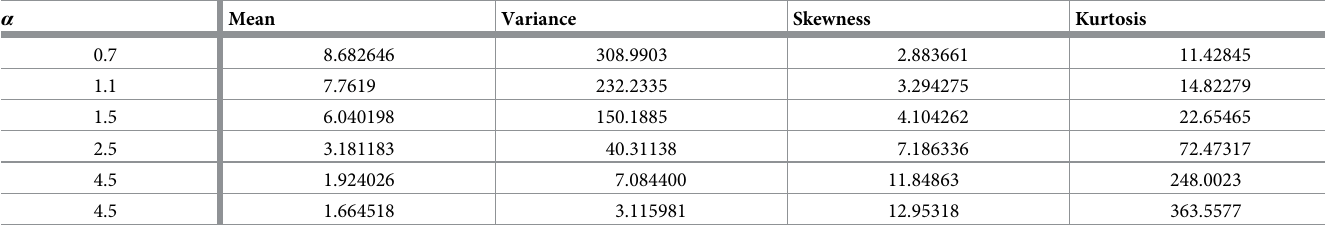
Table 2. Descriptive measures of TI-HTW distribution for θ = 0.5, γ = 1 and different values of α . α